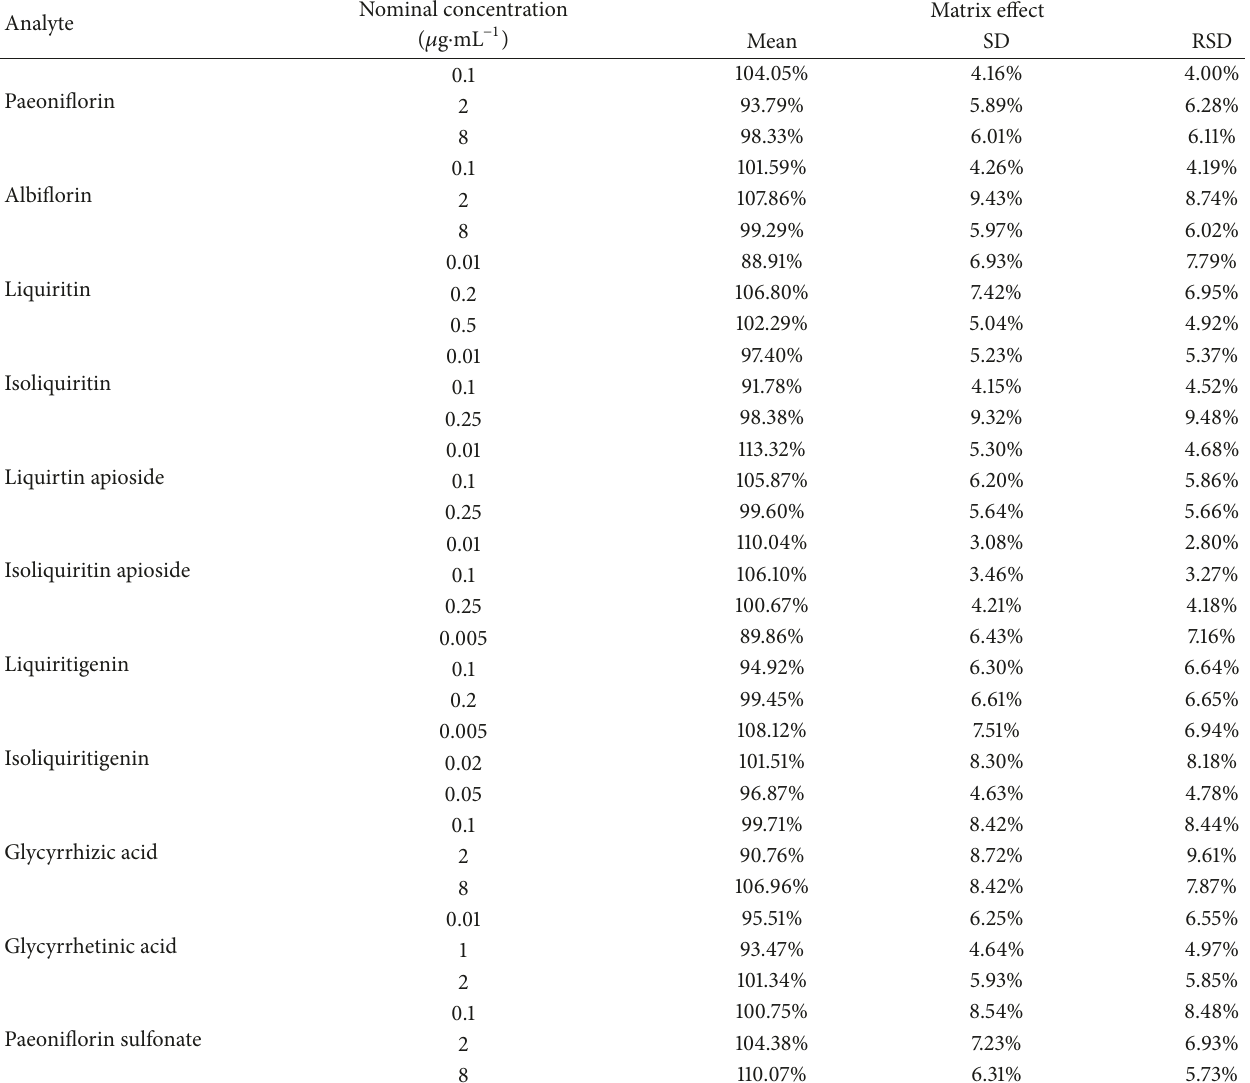
Table 7: The matrix effect of detected compounds in rat plasma.